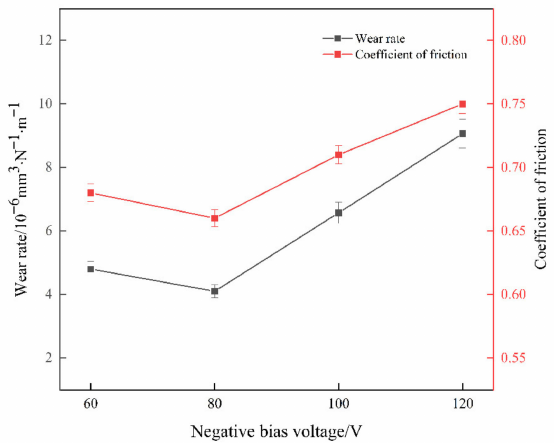
Figure 9. Coating wear rate and average friction coefficient curves at different bias